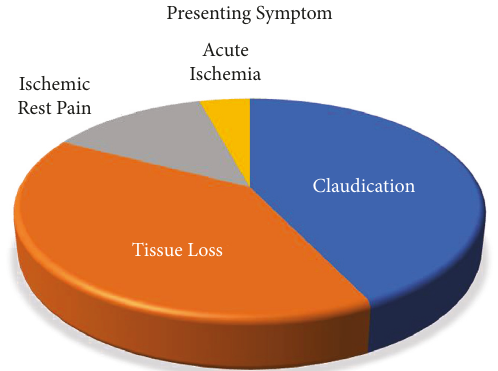
Figure 3: Presenting symptoms. Most common presenting symptoms were claudication and nonhealing ischemic wounds. A minority of patients had ischemic rest pain or acute limb ischemia.